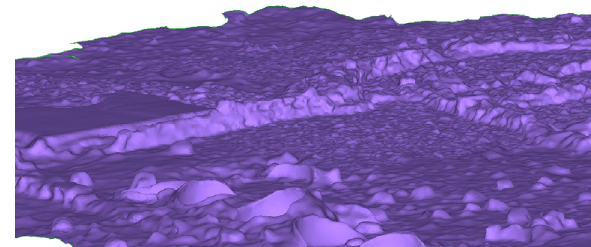
Figure 6: Part of the 3D polygonal mesh of the roman